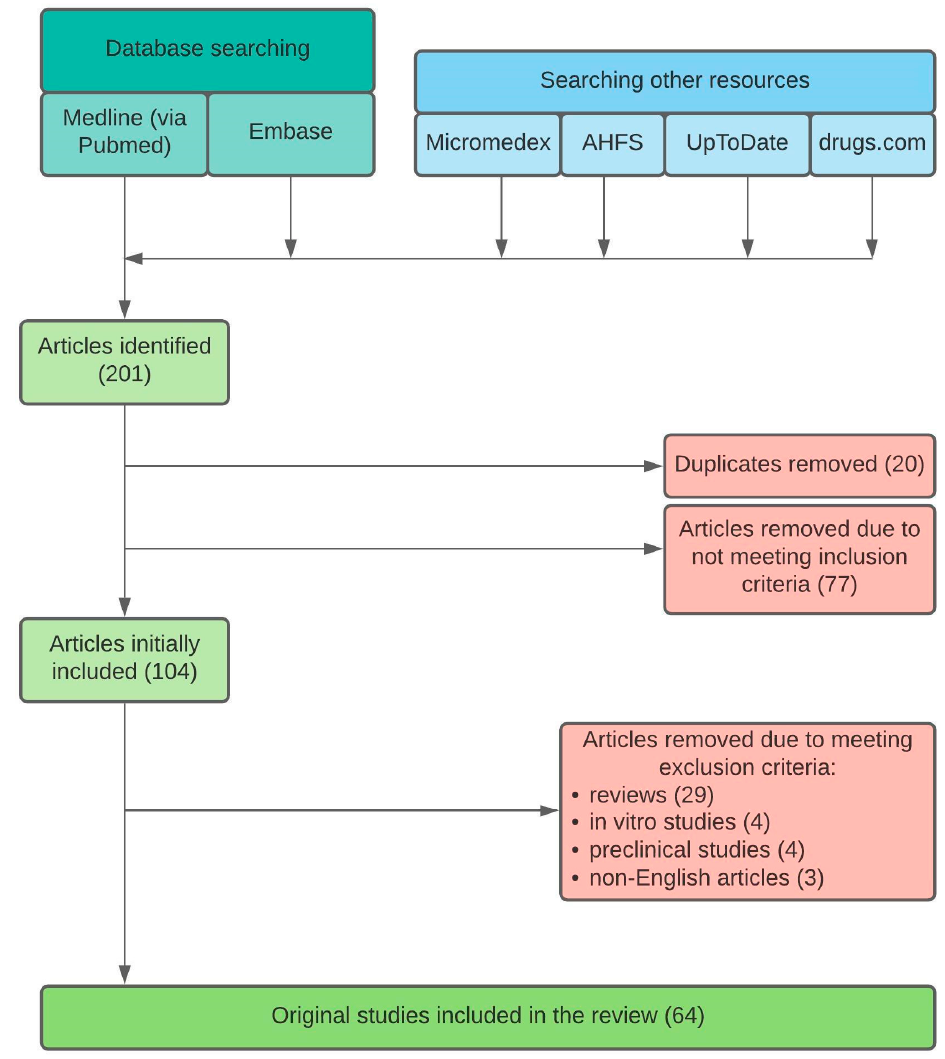
Figure 1. Search strategy flowchart.